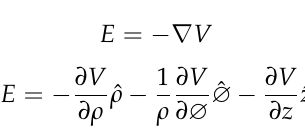
Figure 4. Overlayer agar plate of a preparation of Fersis and enlargement. 3.2. Electrospinning of PEG Loaded with Bacteriophages Electrospinning of PEG samples was initially performed using water (W) as solvent and high polymer concentration due to the low molecular weight of the polymer. A series of experiments at concentrations of 37%, 47%, 50% and 53 wt % were carried out, being representative electrospun fibers attained under typical conditions shown in Figure 5.